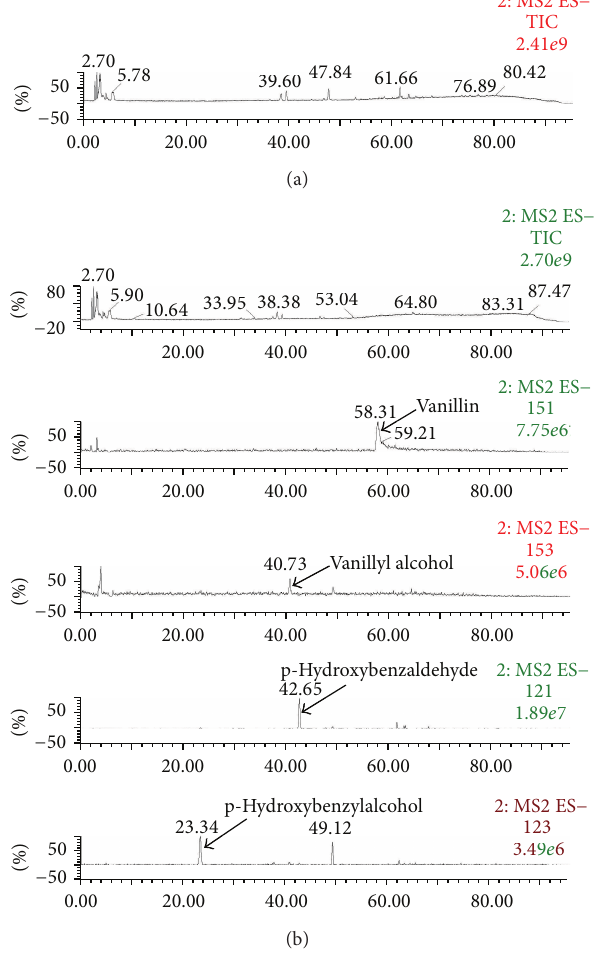
Figure 3: Total ion chromatogram ((a) raw Tianma extract; (b) MWT Tianma extract) and extracted ion chromatograms for rep- resentative phenolics of Tianma with no